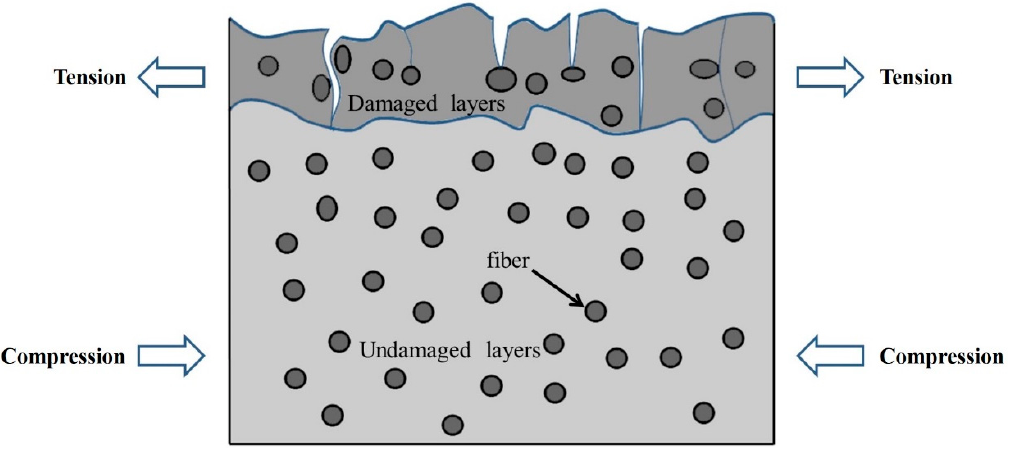
Figure 21. Schematic diagram of damaged layer crack expansion.